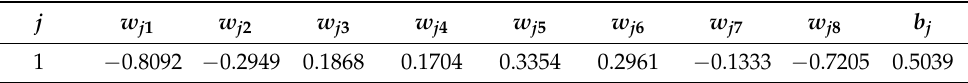
Table 8. Weights and bias of the optimized ANN architecture for the second hidden layer to the output